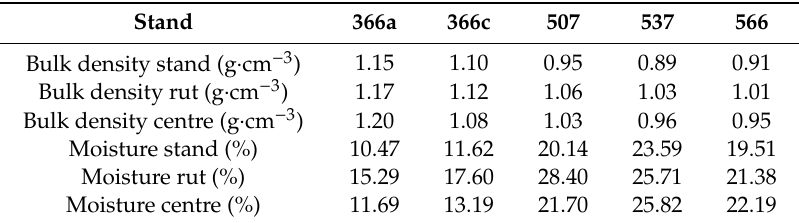
Table 7. Comparison of bulk density and soil moisture measured in stands, ruts, and in spaces between ruts (centre).